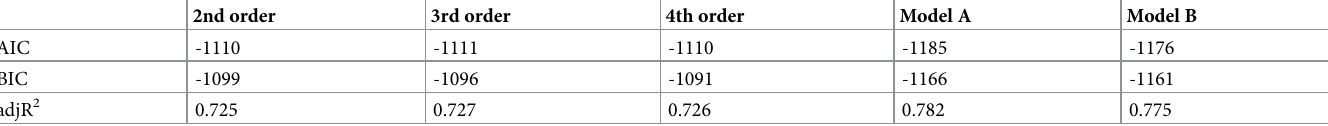
Table 1. Model information criteria